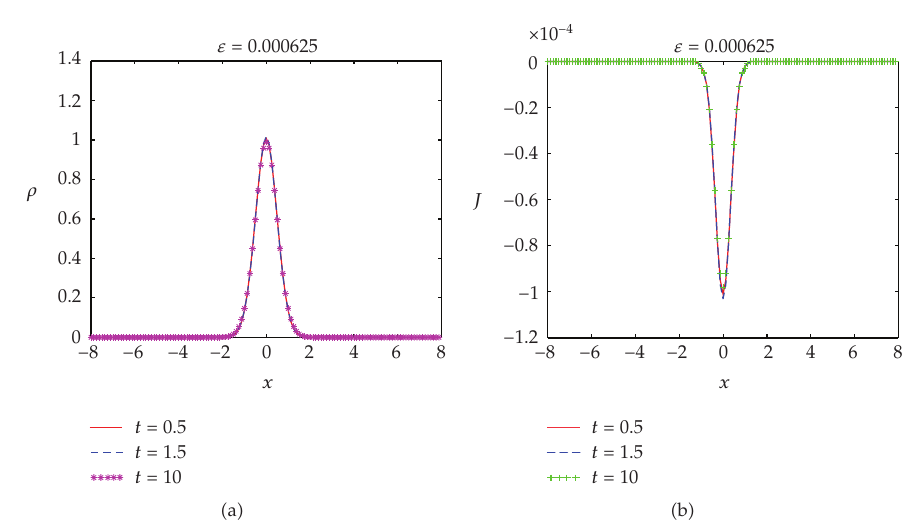
Figure 5: Numerical solutions of Example 5.1 by ED2/EP2 for the weak O (cid:3) ε (cid:4) defocusing nonlinearity (cid:3) ε (cid:6) 0 . 000625 (cid:4)